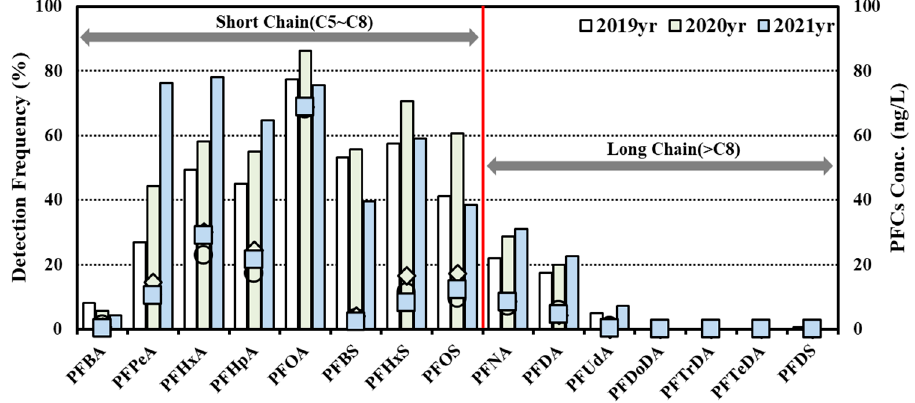
Figure 6. Detection frequencies of PFASs in groundwater.